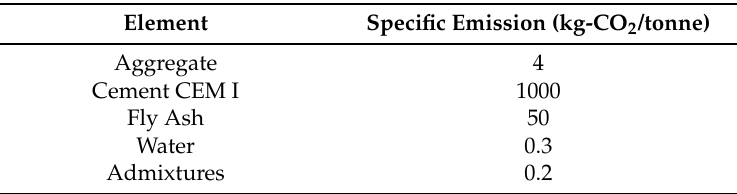
Table 4. CO 2 emissions of concrete constituent in Malaysia [21].